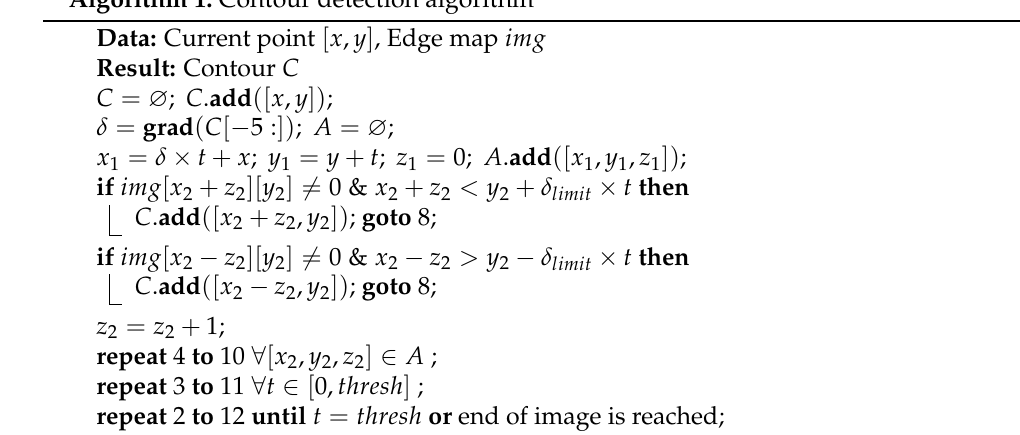
Algorithm 1: Contour detection